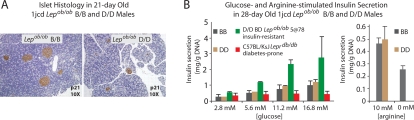
Relationship between Islet Histology and Insulin Secretion.A) Islet histology in 21-day old 1jcd Lepob/ob B/B and D/D male mice. 4 µm pancreatic sections from 21-day old 1jcd Lepob/ob B/B and D/D male mice were insulin-stained with anti-guinea pig IgG and visualized by light microscopy at 10× magnification. In D/D animals, islets were smaller and less numerous. By histomorphometry, the proportion of small islets (250–2000 µm2) in 21-day old Lepob/ob males was greater in D/D (1jc and 1jcd) mice (73%) than in B/B (60%); whereas the proportion of large islets (10,000–50,000 µm2) was lower (9% in D/D and 14% in B/B). B) In vitro glucose-stimulated insulin secretion in pancreatic islets in 28-day old 1jc Lepob/ob B/B and D/D males. Each congenic genotype group consisted of 3 male animals. Negative control consisted of 3 4-week old diabetes-prone Leprdb/db KsJ male animals that are hypo-responsive to glucose stimulation [9]; positive control was 3 4-week old insulin-resistant animals segregating for a diabetes-susceptibility QTL on Chr5 at 78cM, characterized by hyperglycemia and hyperinsulinemia. B/B and D/D show dose response, but no B/B vs. D/D difference at any concentration of glucose. Response to 10 mM arginine in the same animals confirms that the β-cells of the B/B and D/D congenics are comparable with regard to insulin release to a non-glucose stimulus. The 0 mM arginine control in B/B is shown to establish baseline insulin levels.